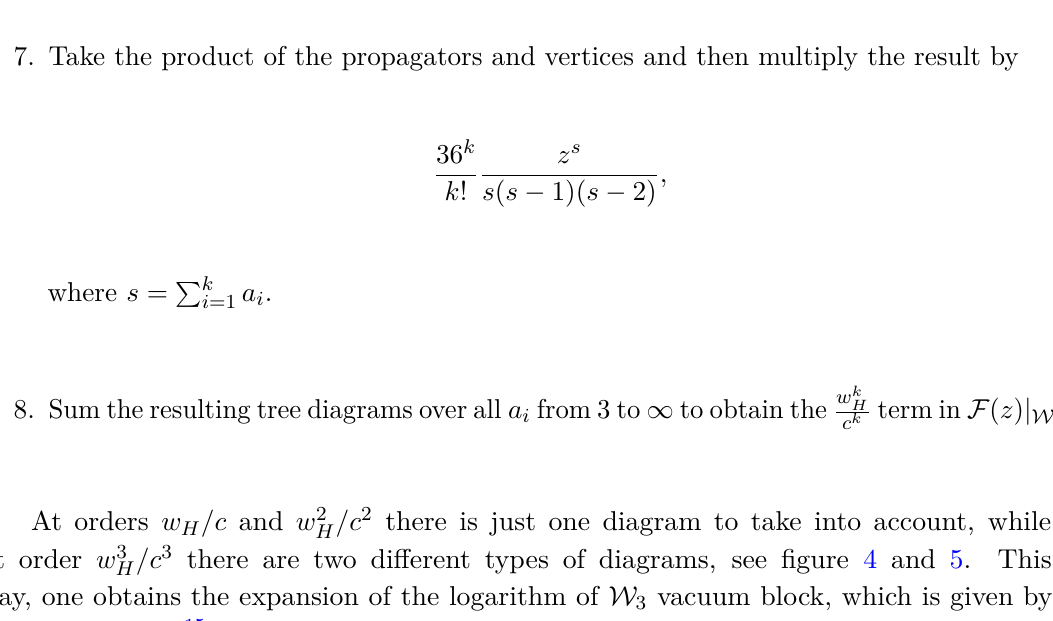
Figure 3 . Vertices denoting 3-pt and 4-pt coupling of currents,